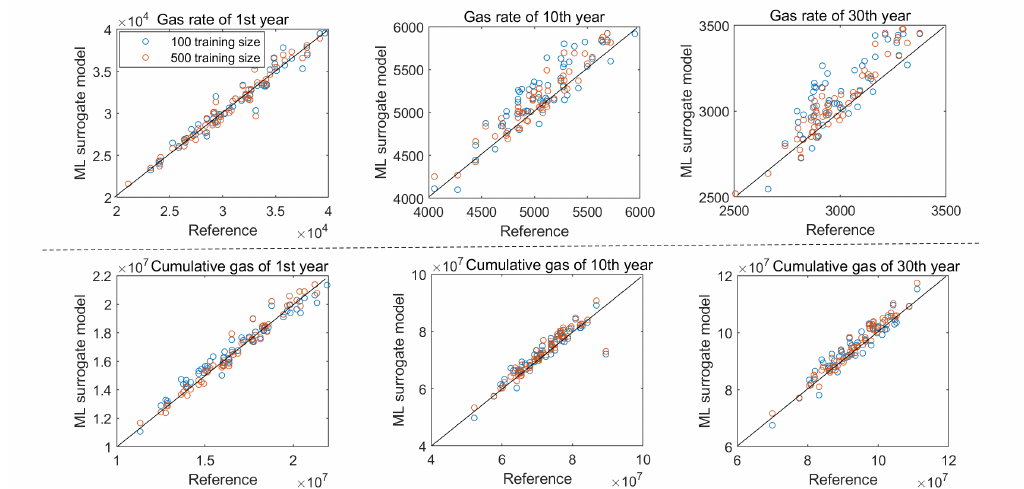
Figure 7. Forecast results of daily production and cumulative production of shale gas at different production periods (i.e., the 1st, 10th and 30th years). The black line represents the accurate prediction of the true value, and the red and blue scatter points represent the machine learning prediction value.